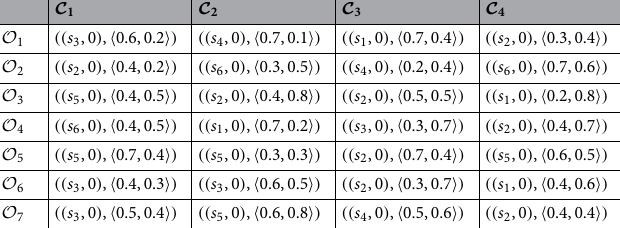
Table 2. q-ROPFL data provided by D 2 .